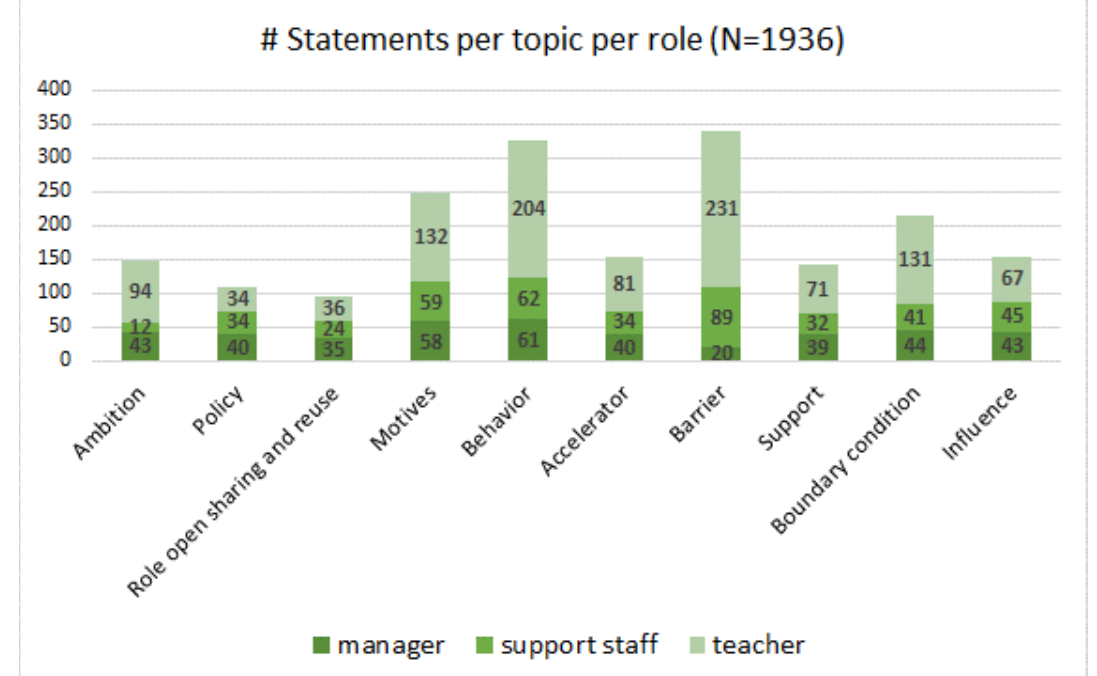
Figure 3. Distribution of